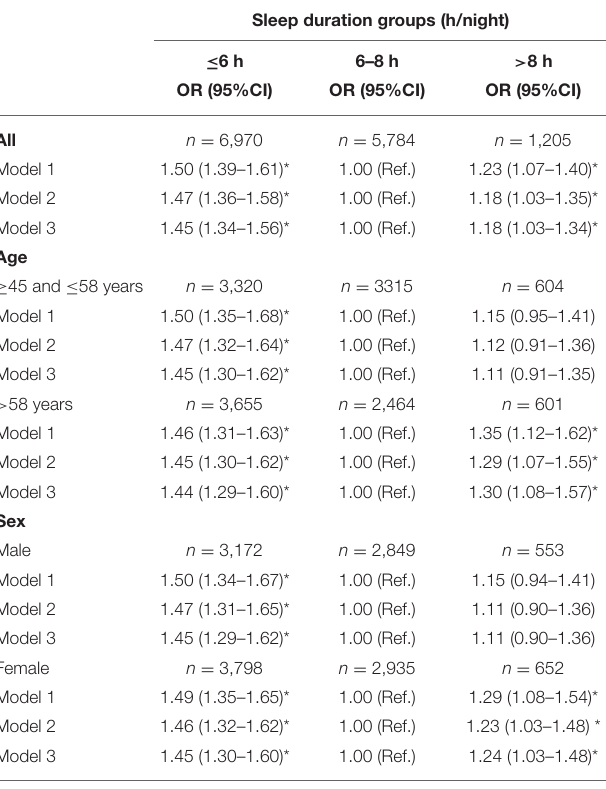
TABLE 3 | Associations between sleep duration and risk of vision impairment in middle-aged and elderly Chinese (CHARLS